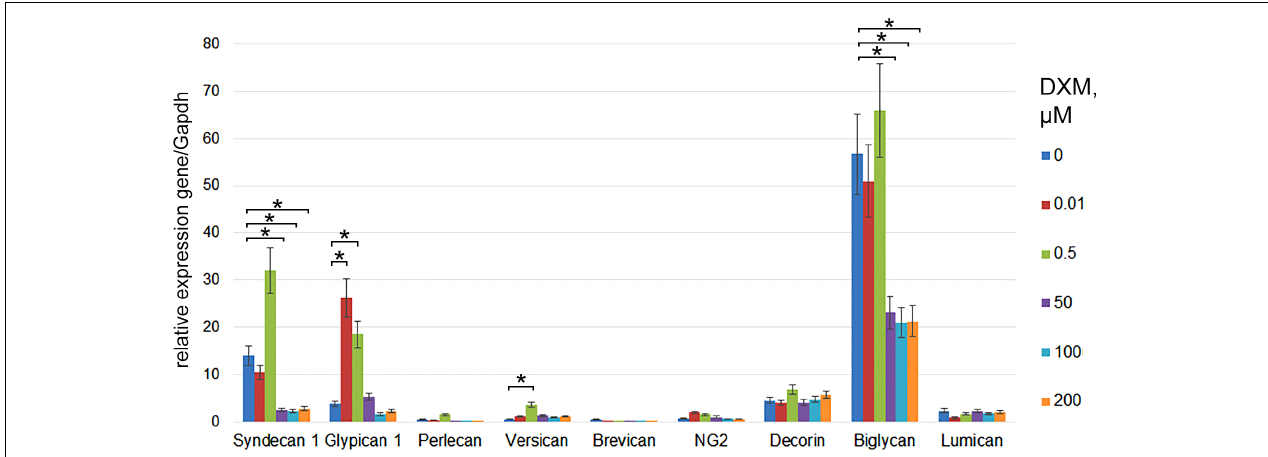
FIGURE 1 | PGs expression levels in organotypic rat hippocampus cultures ex vivo before and after treatment with various concentrations of DXM. RT-PCR analysis, intensity of the amplified DNA fragments normalised to that of Gapdh . Bars represent the mean ± SD from triplicate experiments (OriginPro 8.1). Student’s t -test, ∗ p <